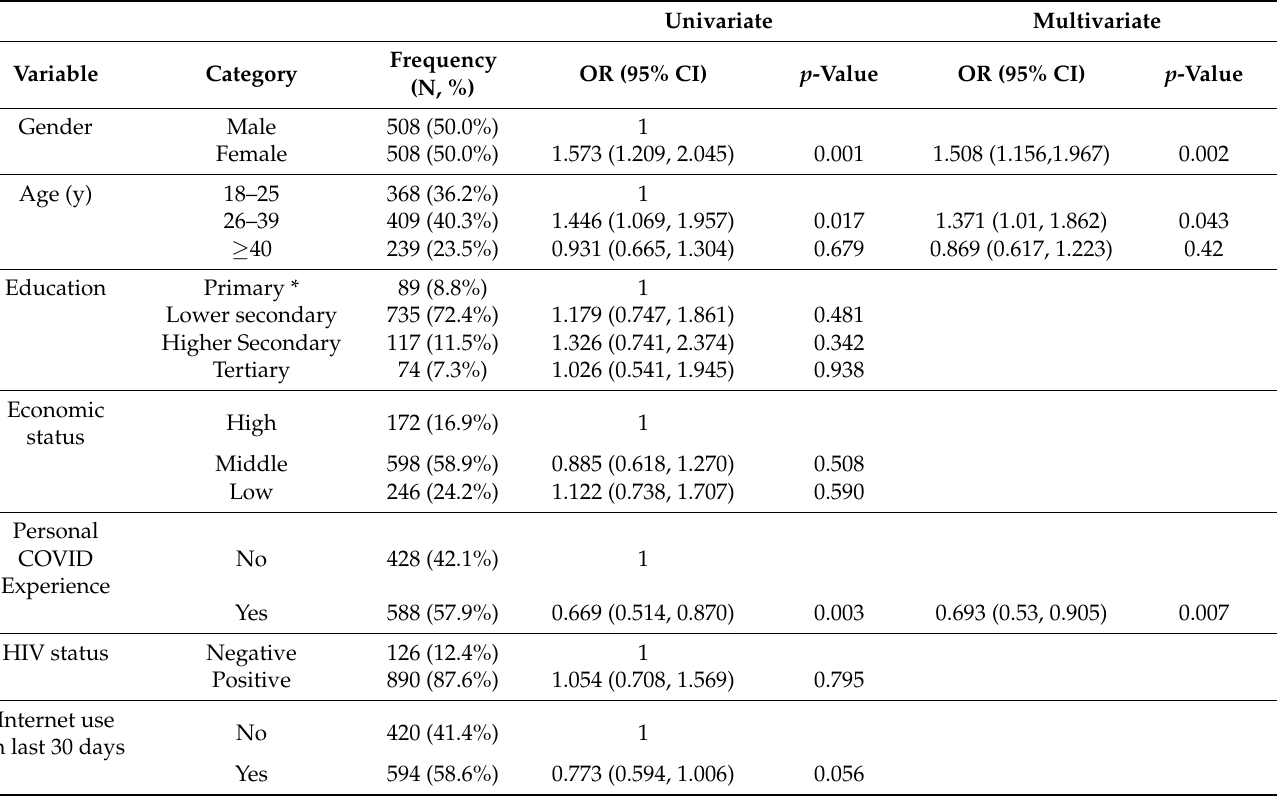
Table 2. Factors associated with having a very negative or somewhat negative view towards COVID-19 vaccines when they first became available. Univariate